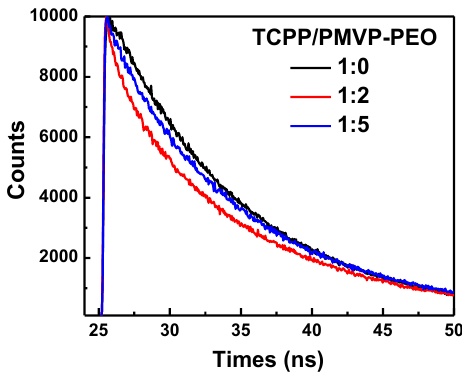
Figure 6. Fluorescence decay time of TCPP and TCPP/PMVP-PEO at different charge ratios of 1:0, 1:2, and 1:5. PMVP-PEO is an abbreviation of PMVP 41 - b -PEO 205 .